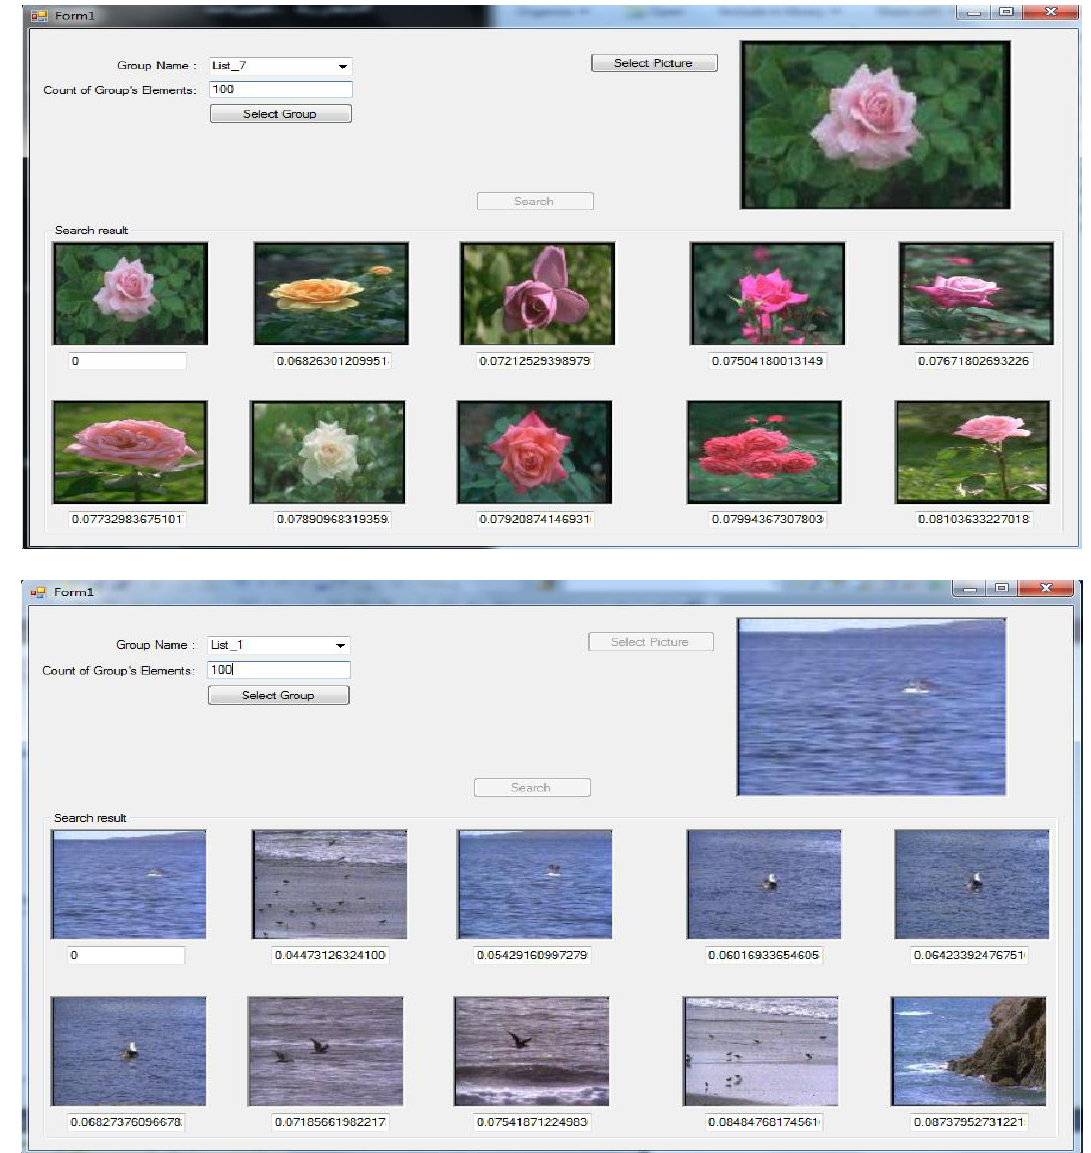
Figure 2. Some sample images which have been retrieved by the proposed